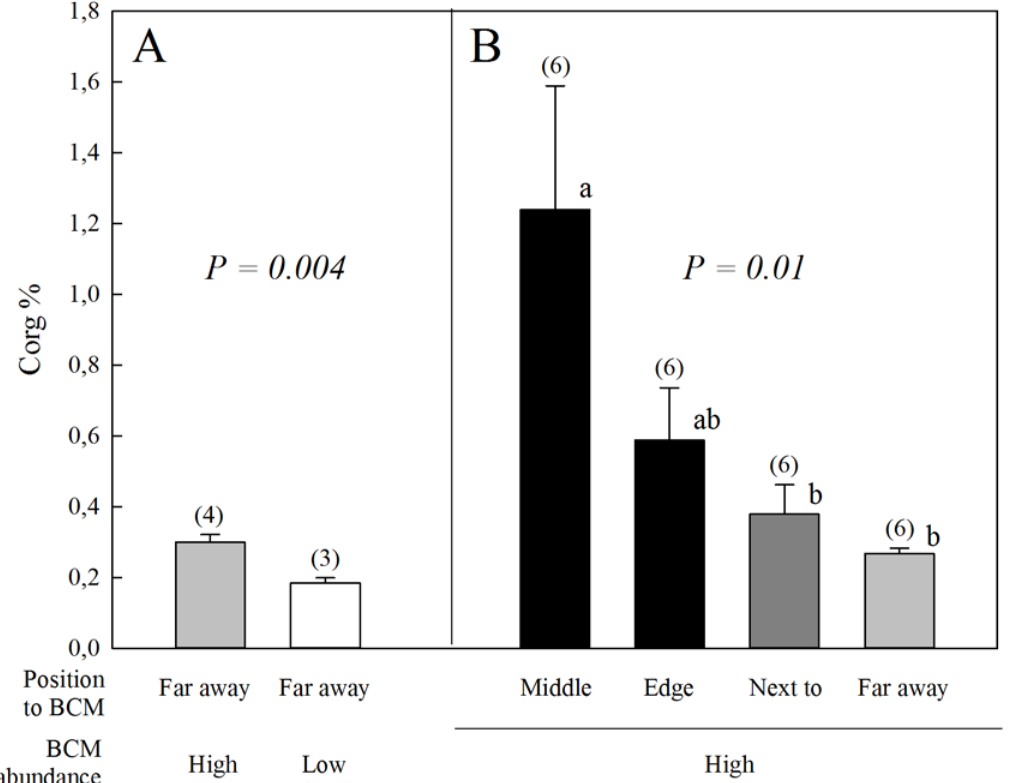
Fig 3. Organic matter content in sediments. Percent organic carbon (C org ) (mean ± SEM) of (A) sediment cores collected far away ( > 5 m) from any BCM patch at sites of low and high BCM abundance, and (B) sediment cores collected at Pestbay (site of high BCM abundance) in the middle, edge, next to (ca. 10cm away) and far away ( > 5 m) from BCM patches. Analysed by ANOVA. Letters indicate homogeneous subgroups by posthoc Scheffe tests. Numbers of replicates are in